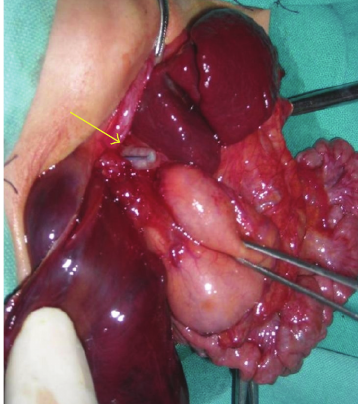
Figure 2: Operative photograph showing a blind ending of the lower esophagus with a sealed perforation